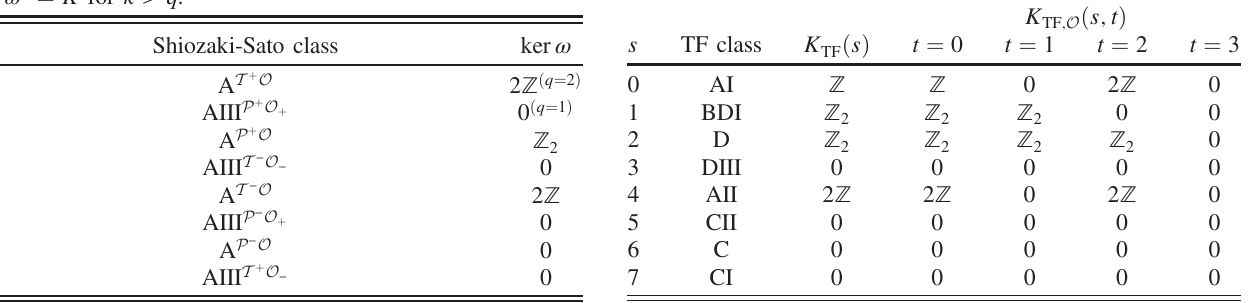
s j 0 ; 0 Þ and K s; t j 0 ; TF ð TF ; O ð